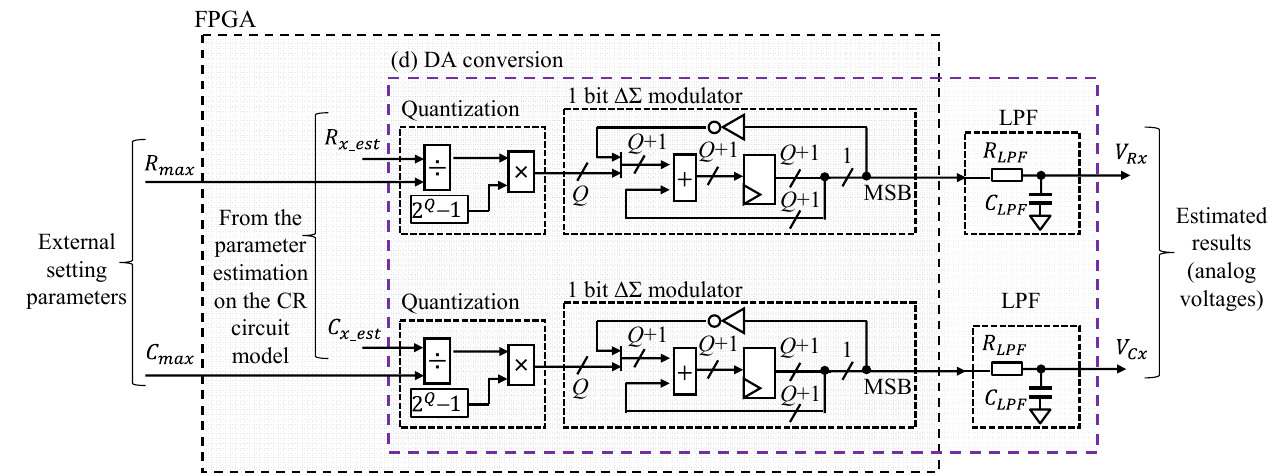
Figure 5. Detailed illustration of the DA conversion written in Figure 1.